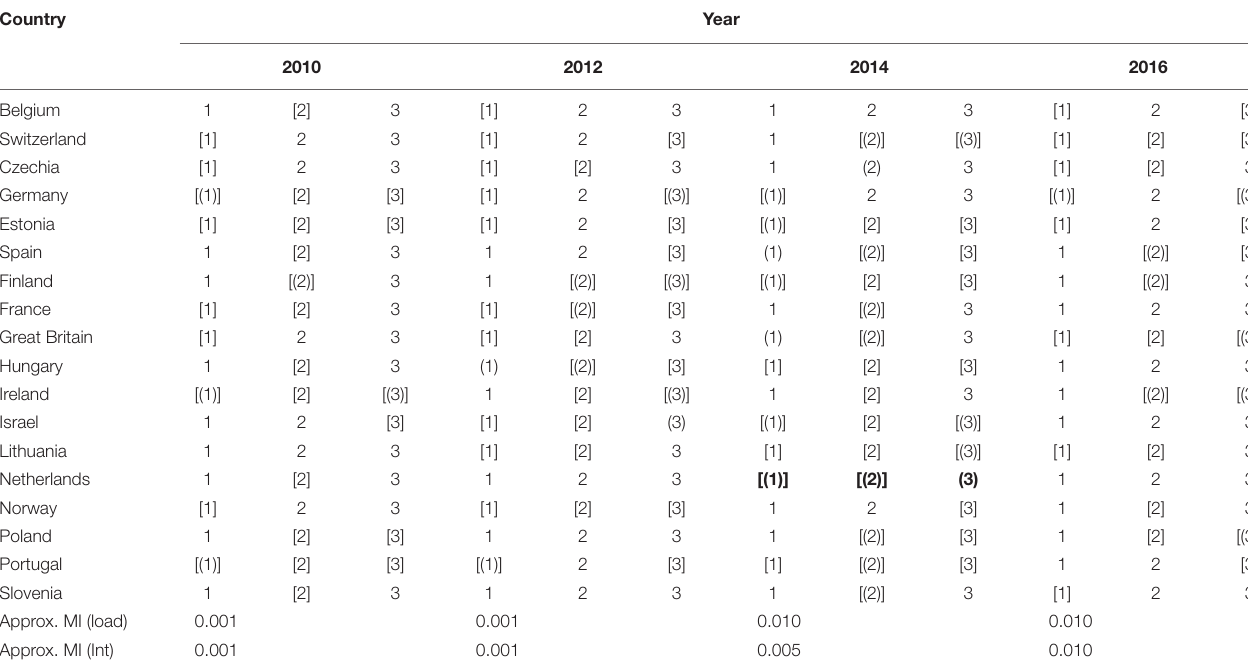
TABLE 4 | General threat index, between country